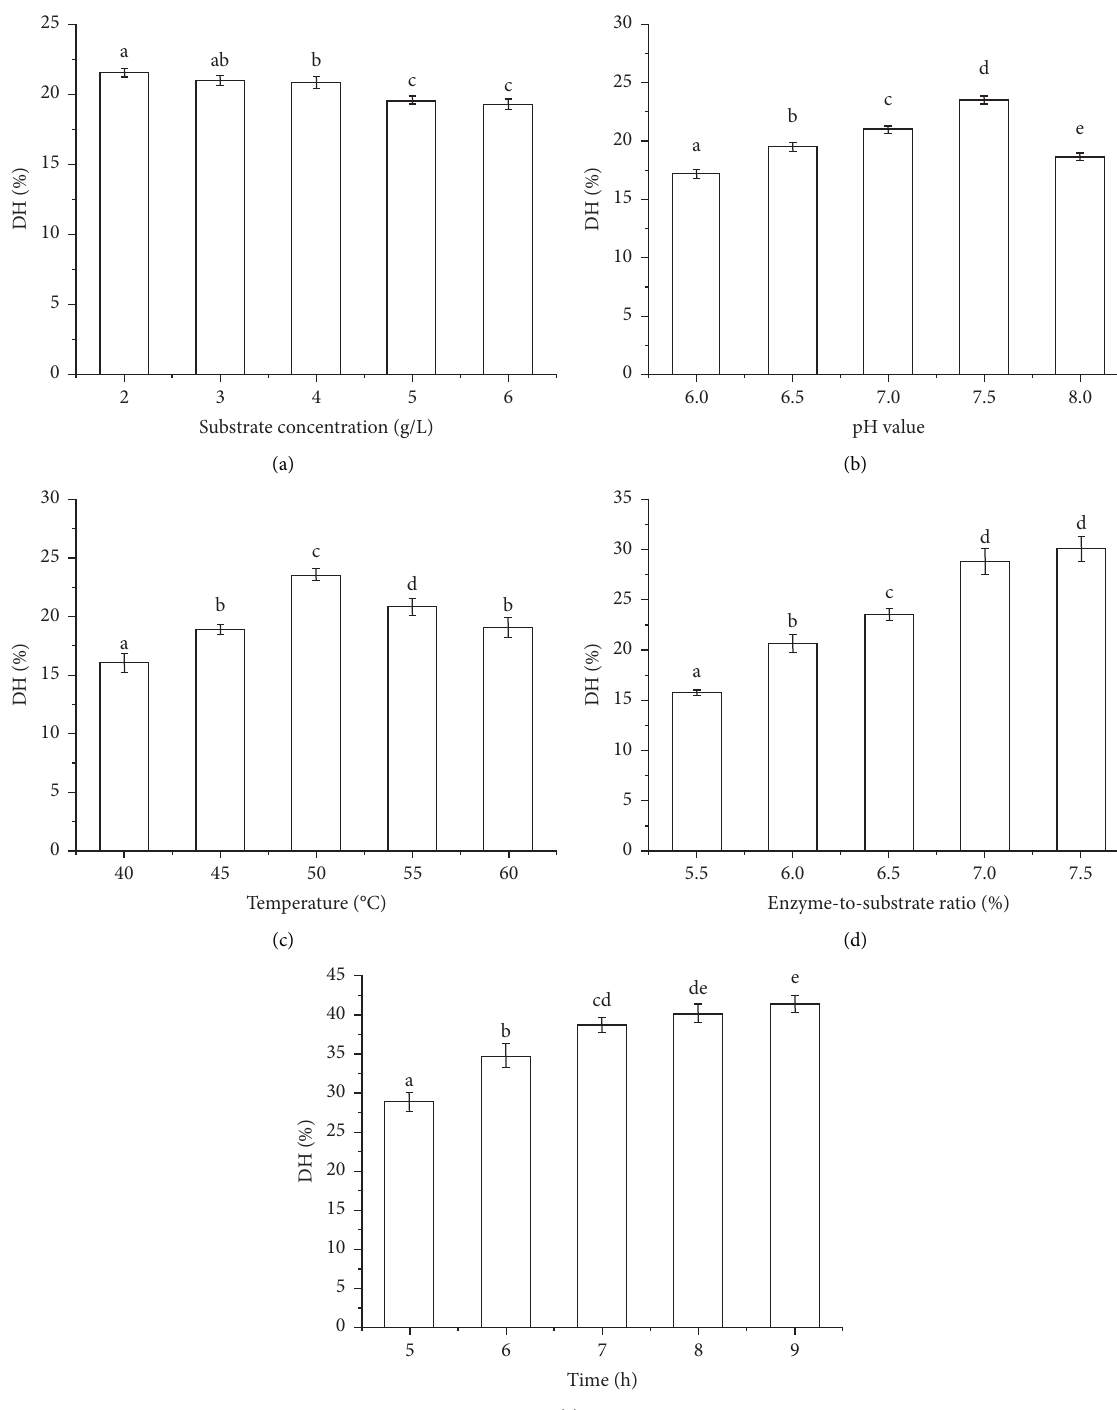
Figure 1: Single factor experimental results of enzymolysis conditions: (a) substrate concentration, (b) pH value, (c) temperature, (d) enzyme-to-substrate ratio, and (e) time. Means with different superscripts are significantly different ( p < 0 .